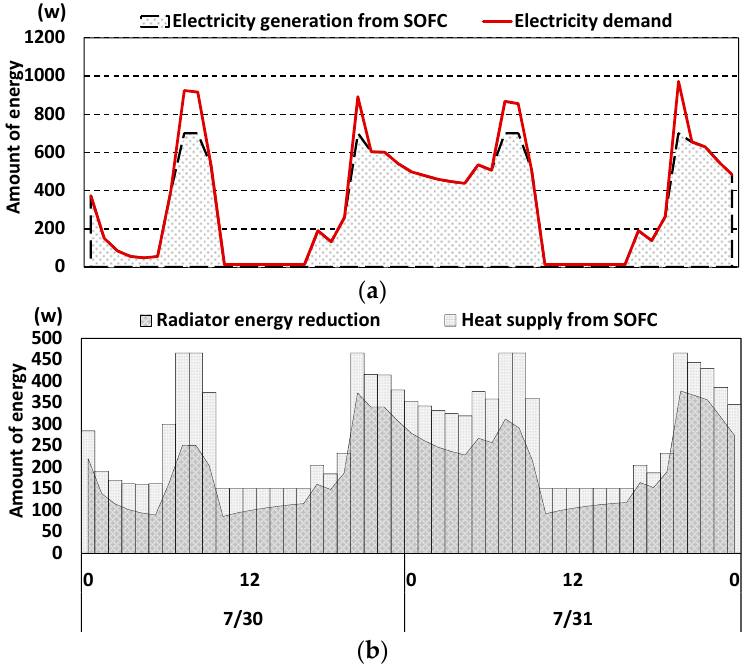
Figure 9. Hourly simulation data of household 2. ( a ) Data of electricity generation and electricity demand; ( b ) Data of heat reduction and heat